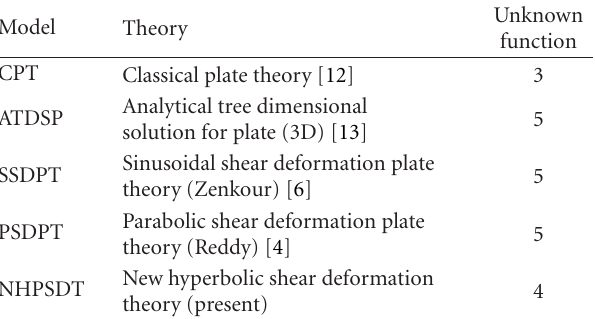
Figure 1: Geometry of rectangular plate composed of FGM.